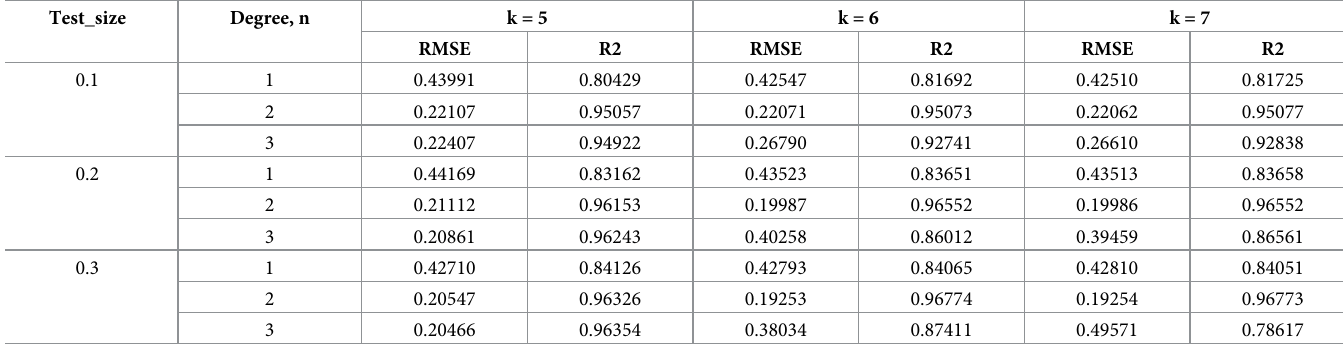
Table 7. RMSE and R2-score in polynomial